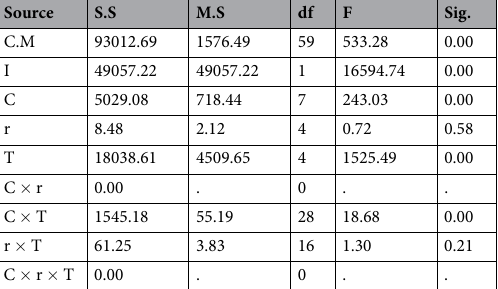
Treatments (Conc.)